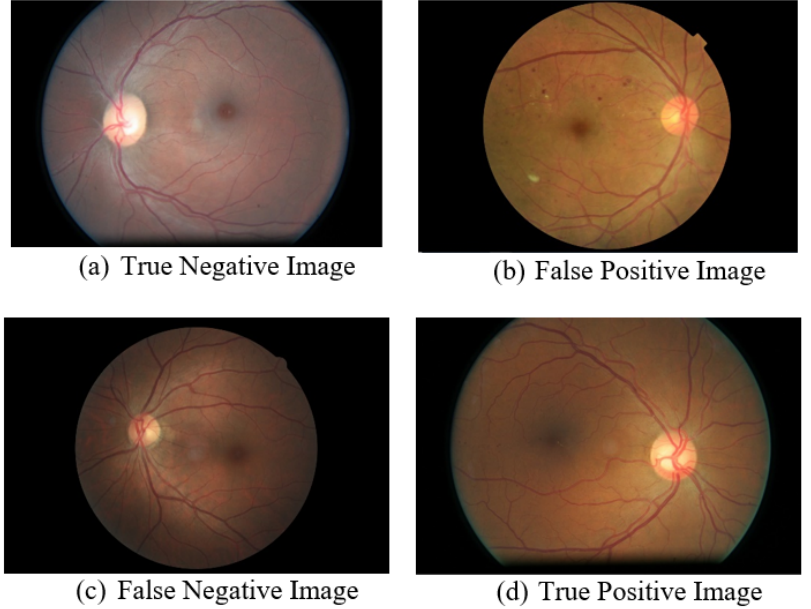
Figure 4. Results of classified images reviewed by clinical experts.